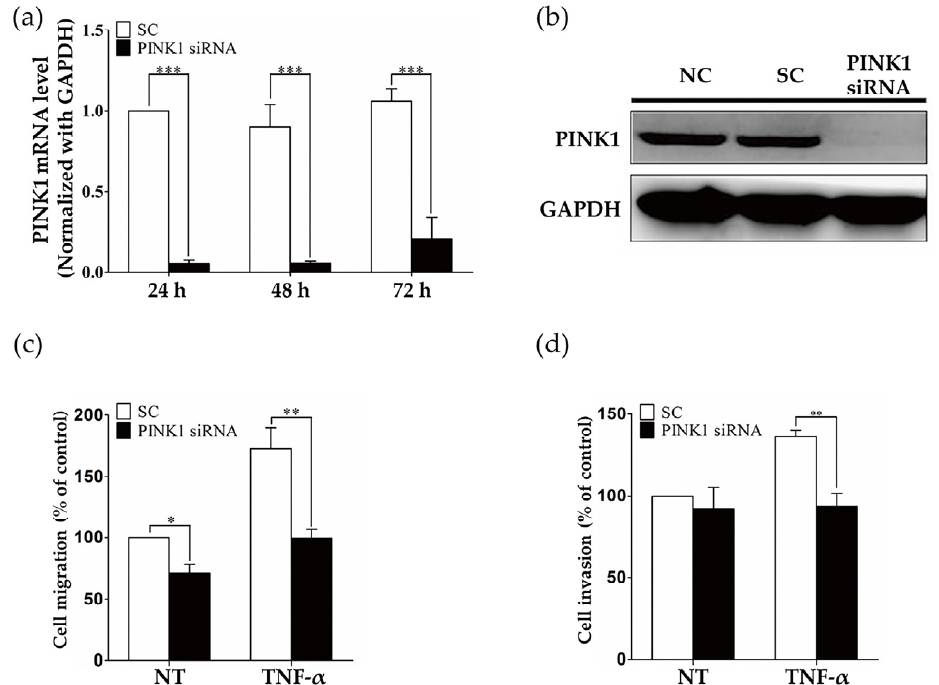
Figure 3. PINK1 ablation impairs RASF migration and invasion. ( a ) Real-time PCR measurement of PINK1 mRNA demonstrated that siRNA knockdown of PINK1 successfully decreased PINK1 mRNA levels. In total, 10 nM PINK1 siRNA was transfected into RASFs for 24 h, 48 h, and 72 h. Data are expressed as means ± SEM for three independent experiments. ** p < 0.01; *** p < 0.001. ( b ) Western blot quantification of PINK1 protein demonstrated that PINK1 siRNA knockdown decreased PINK1 protein levels. In total, 10 nM PINK1 siRNA was transfected into RASFs for 24 h. Data are representative of at least three independent experiments. ( c , d ) Cell migration and invasion assay in PINK1 knockdown RASFs. RASFs were transfected with scramble (sc) or PINK1 siRNA and stimulated with TNF- α (10 ng/mL). Data are expressed as means ± SEM for three independent experiments. * p < 0.05 *** p < 0.001.